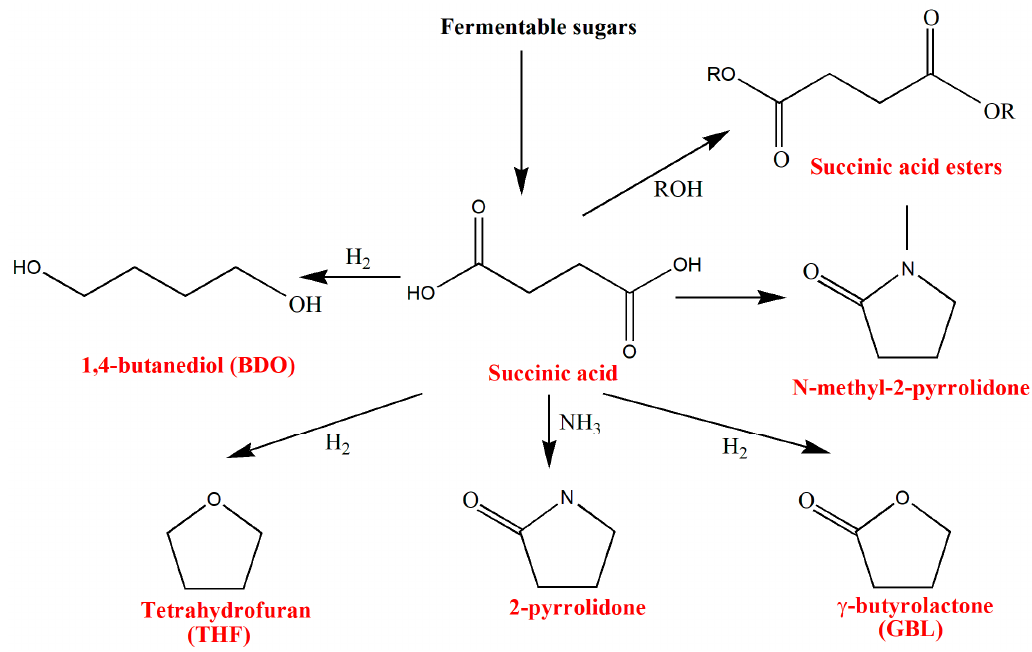
Figure 12. Succinic acid and its derivatives [224–230].